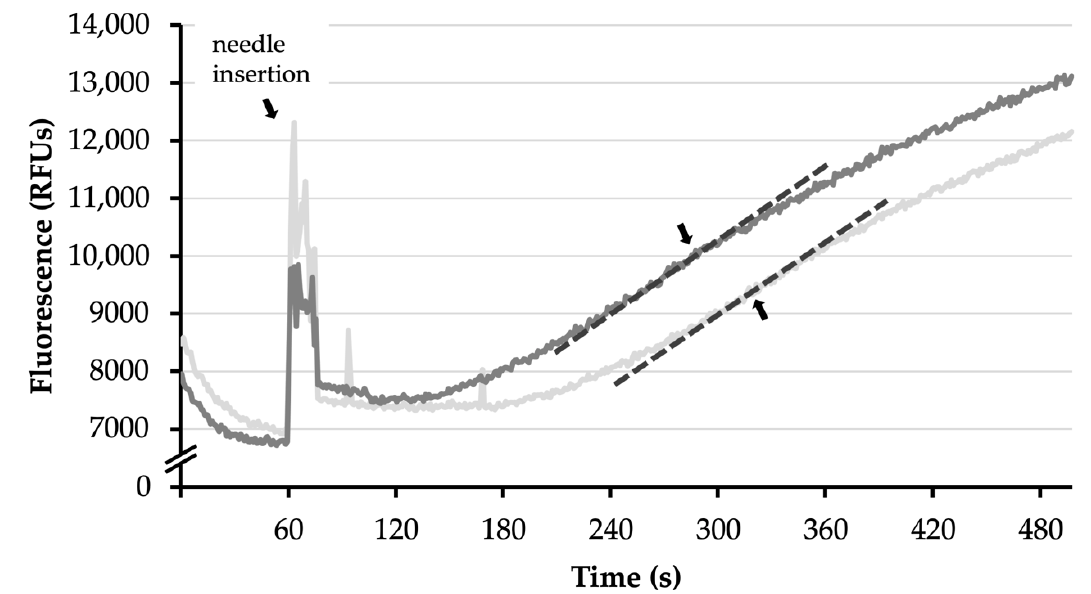
Figure A3. Calcium retention capacity (CRC) is defined as the maximal amount of calcium (Ca 2+ ) that can be kept inside mitochondria. With the insertion of the needle into the cuvette, calcium chloride (CaCl 2 ) is pumped at a continuous rate into the mitochondrial suspension. Extramitochondrial Ca 2+ binds Calcium Green TM . This results in increased fluorescence measured in relative fluorescence units (RFUs). The highest slope (dotted lines) indicated the moment at which mitochondrial permeability transition (MPT) occurred in most mitochondria. This allowed calculation of the amount of Ca 2+ infused into the mitochondrial suspension until this point.